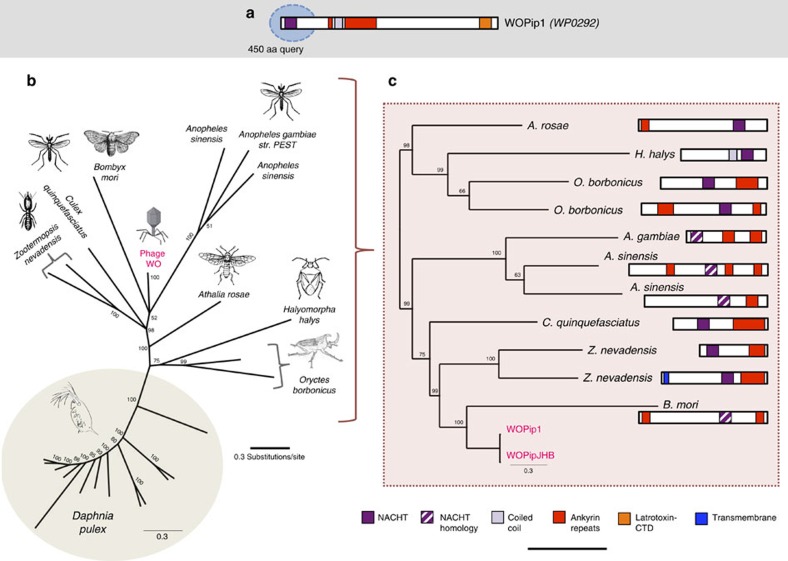
Phylogeny and protein architecture of the cell death domain, NACHT.(a) A BLASTP query of prophage WO's NACHT region reveals homologues throughout arthropods and crustaceans. (b) Bayesian phylogenetic trees were constructed based on a 271-aa alignment of all homologues with E-value <e−15 and coverage >70% using the cpREV+G model of evolution. To resolve taxa closest to prophage WO, all Daphnia sequences were removed from the alignment and clusters of highly divergent residues (that is, five or more sequential residues with <15% pairwise identity) were trimmed. (c) Trees were reconstructed based on this 262-aa alignment using the LG+G model of evolution. Consensus support values are shown at the nodes. Both trees are unrooted. Chromosomal neighbourhood analyses of available animal genome sequences indicate that animal homologues to the prophage WO protein are on contigs with other animal genes. Scale bar, 1,000 amino acids.